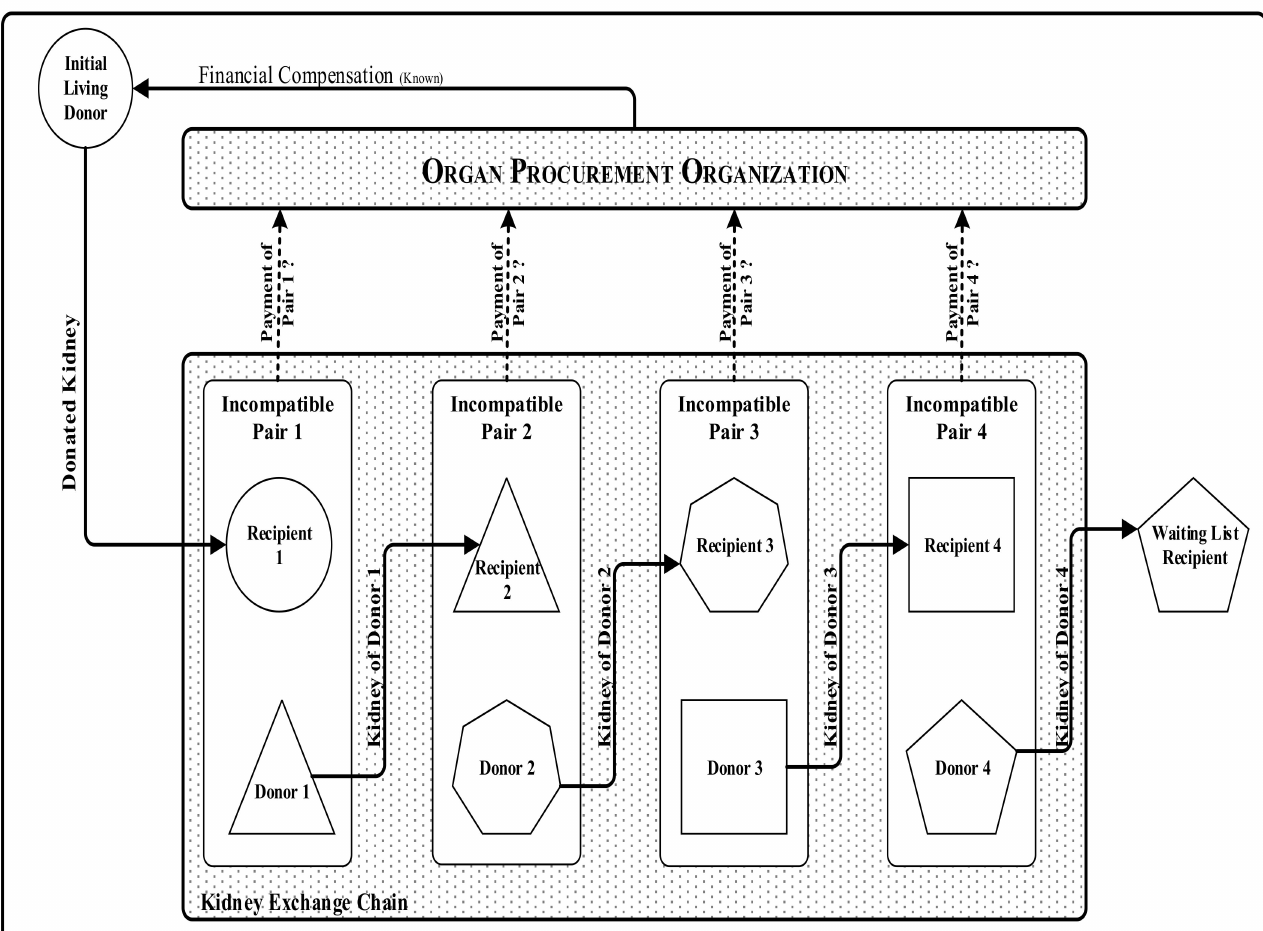
Figure 1. An illustrative statement of the problem under investigation. A kidney-exchange chain with one initiating living donor, four incompatible pairs and a waiting-list recipient. Each incompatible pair makes a payment to the organ- procurement organization, and the total compensation is paid to the initiating